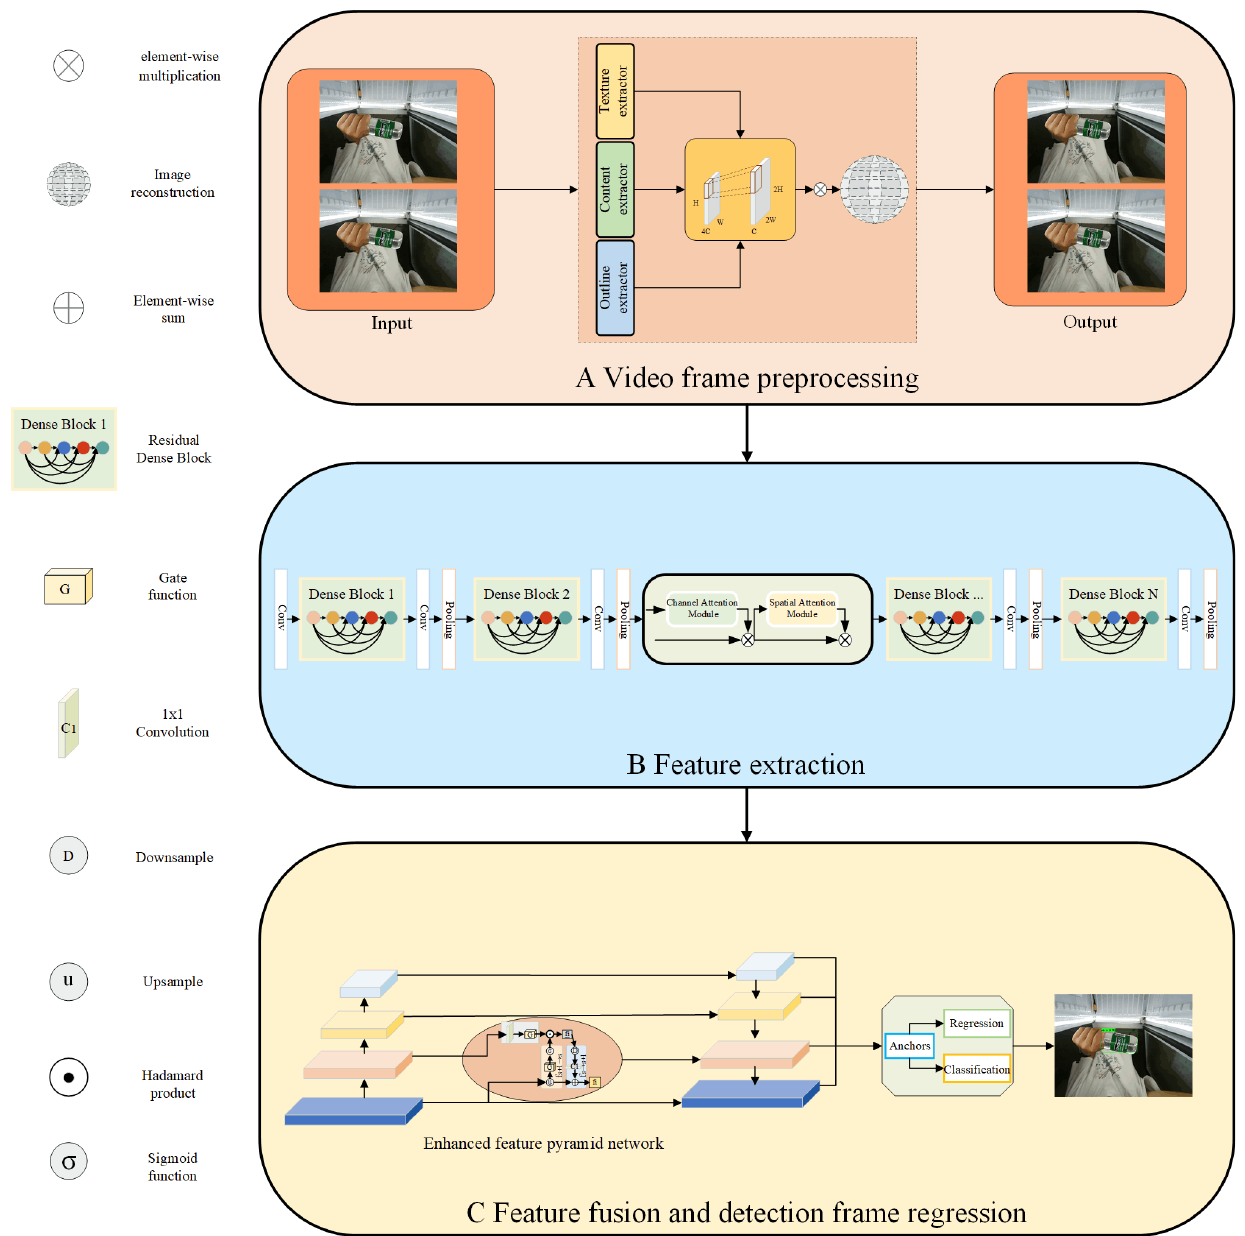
Figure 1. Algorithm flow. ( A ) The input video frames are first preprocessed to obtain the SR images. ( B ) Residual dense blocks are used to extract features from SR images and extract feature information for different dimensions of commodities through the CBAM. ( C ) The feature pyramid network enhances the small commodity region of the shallow feature map, and the fusion of multi-scale feature maps is used to classify the commodities by adaptive regression. Downsample denotes the downsampling operation on the feature map. Upsample denotes the upsampling operation on the feature map.